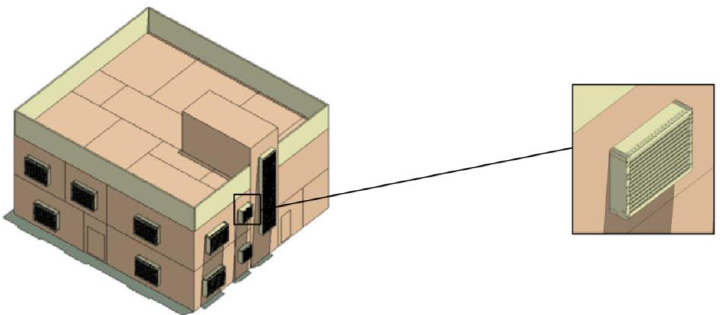
Figure 14. 3D isometric of the base house featured with mushrabiyahs.